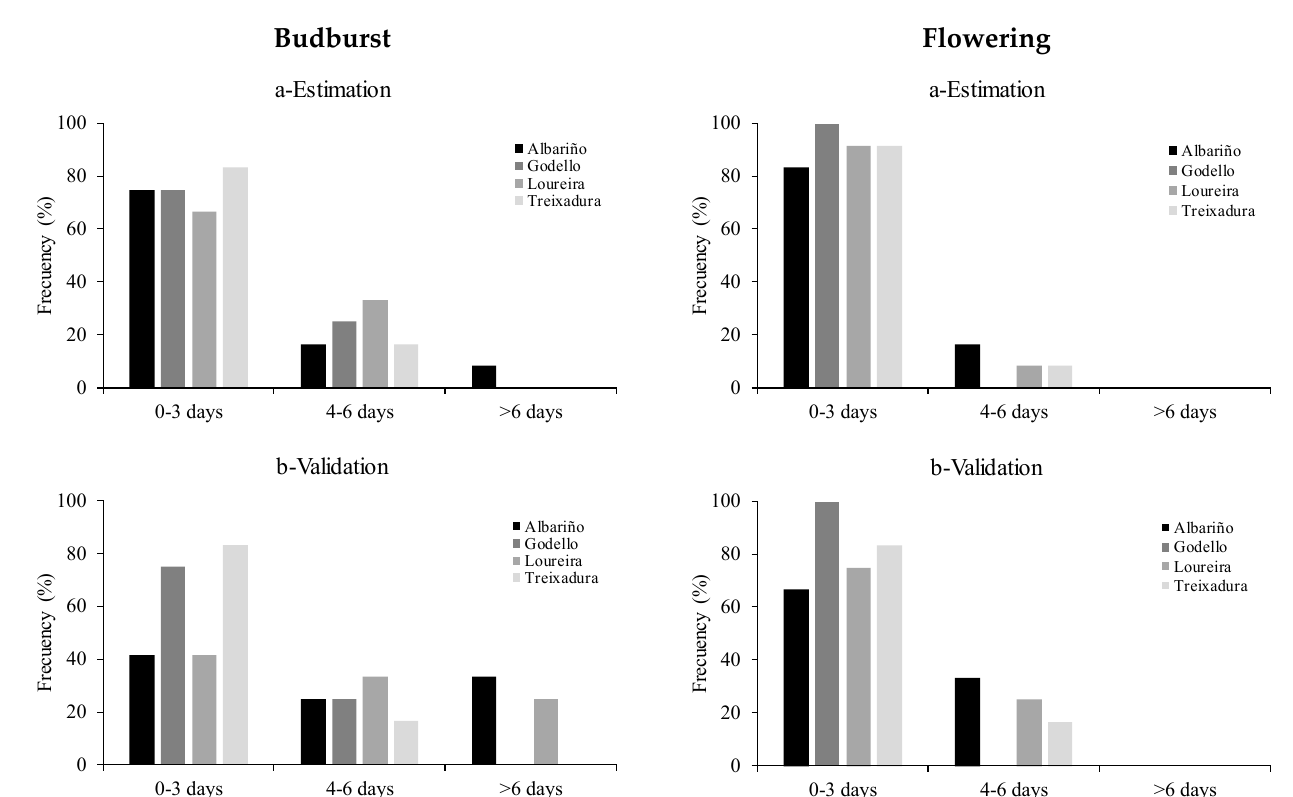
Figure 2. Frequency in the percentage of difference in days between predicted and observed budburst and flowering dates for grapevine varieties, a - used in the GDD model estimation by budburst and flowering b - and for GDD validation using the best-fitted model (Treixadura for budburst and Godello for flowering) with the other grapevine varieties.